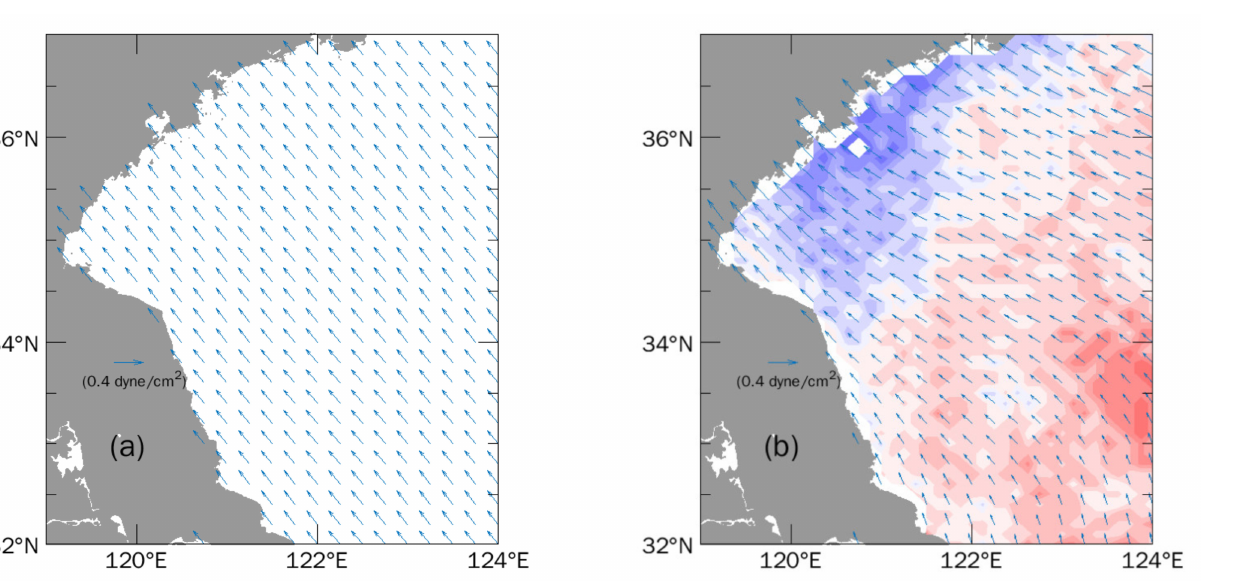
Figure 10. ( a ) Constant wind stress field in Exp.cw and ( b ) shear wind stress field in Exp.curl with color-filled wind stress curl. Red and blue shades represent positive and negative values,